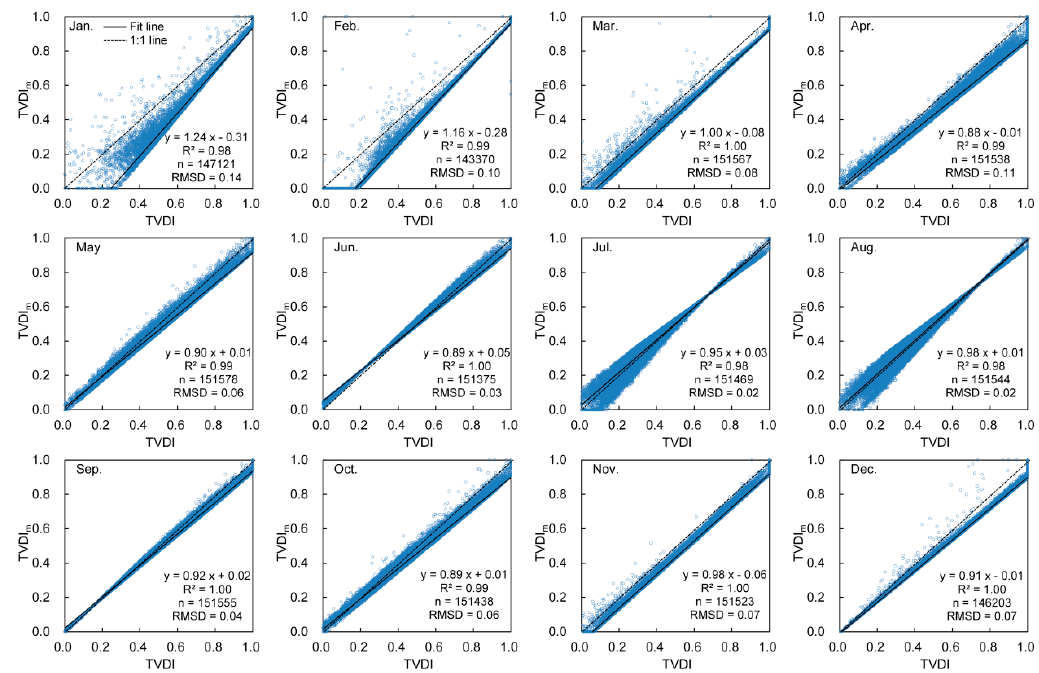
Figure 15. Scatterplots of TVDI and TVDI m and their relationship in 2005.